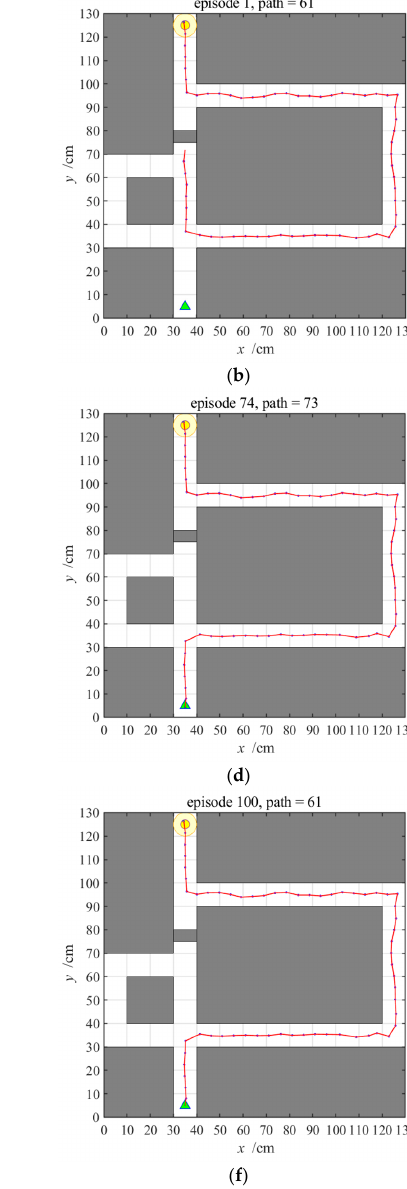
Figure 21. Navigation path with the NLM-HS when door B is closed; ( a ) shows the agent’s encounter with the closed door B, and ( b ) shows the new navigation path from current position, both of which constitute the first navigation path. In addition, ( c – f ) show navigation paths in the 2nd, 74th, 80th and 100th episodes, respectively. The episode number and the path length measured by the steps in each experiment are shown at the top of the panels.